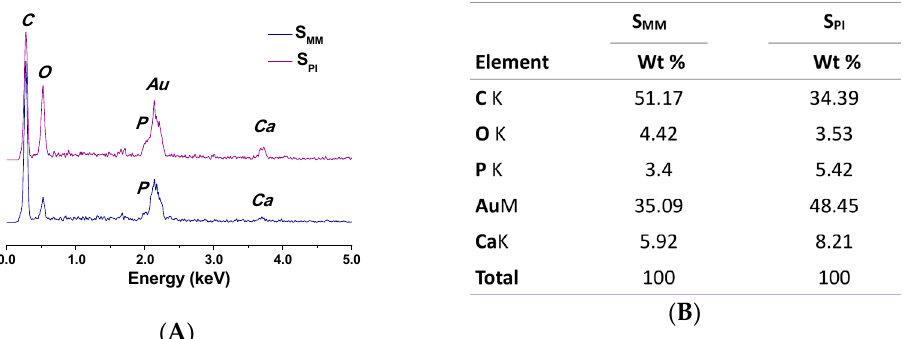
Figure 3. EDX spectra ( A ) and element contents ( B ) of S PI and S MM .